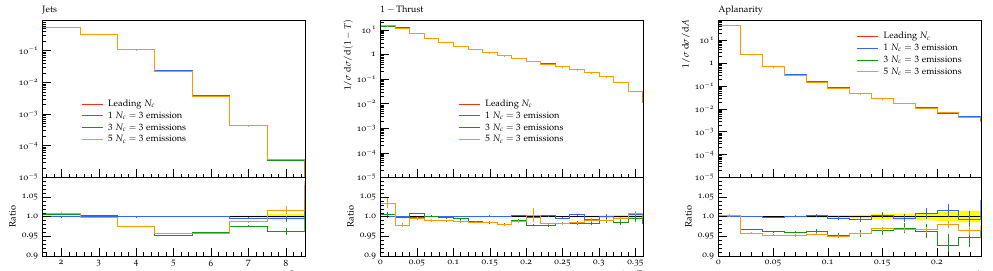
Figure 4 . Parton level plots for fraction of LEP-events containing n jets with E > 5 GeV (left), thrust (middle) and aplanarity (right), the jets have been clustered with the anti- k ? -type generalized e + e (cid:0) clustering algorithm with R = 0 : 7. For hadronized events the e(cid:11)ect on thrust vanishes, whereas the e(cid:11)ects on number of jets and aplanarity are somewhat reduced. Note that the case of one full N c emission should agree with the leading N c shower, as is